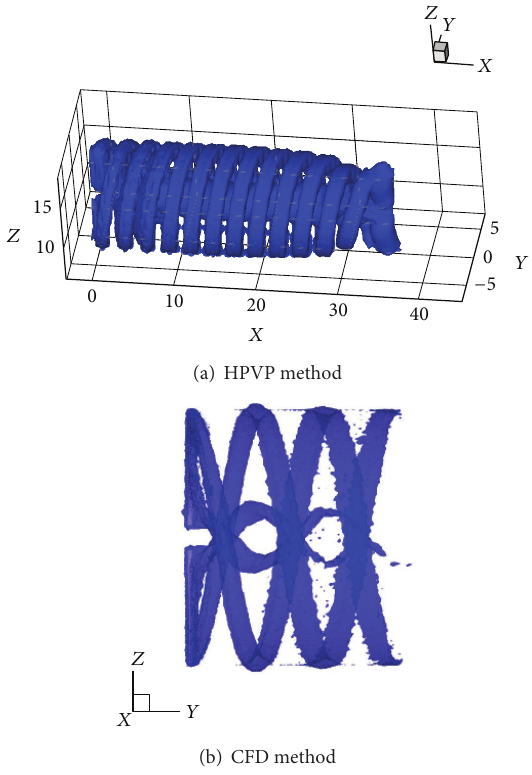
Figure4:Wakevortexcomparisonindifferentcalculationmethods.